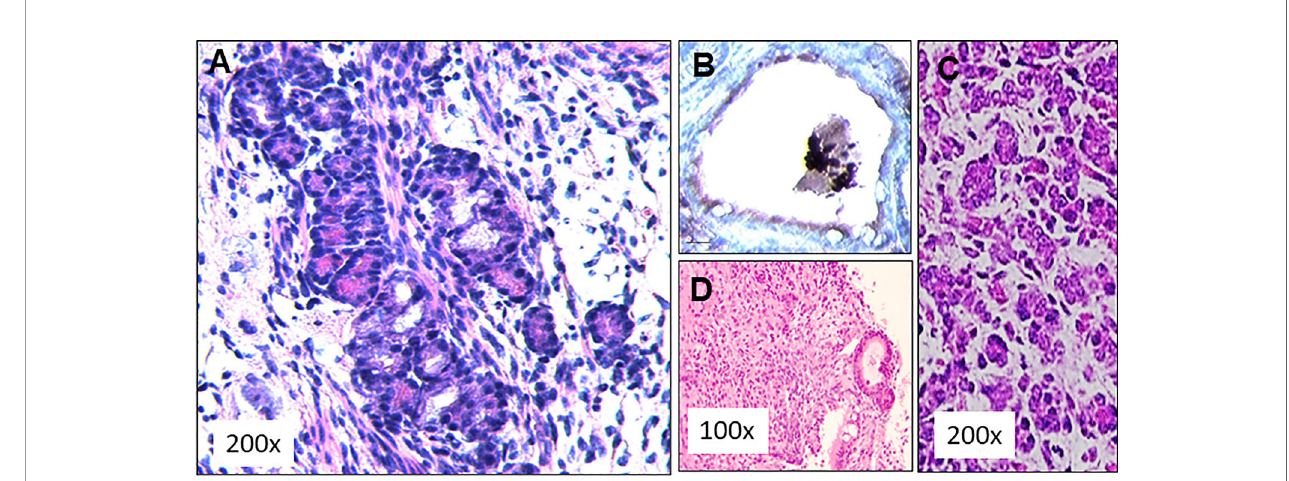
FIGURE 6 | SCID mouse transplant histology. (A) Subcutaneously implanted dermal tissue was analyzed histologically for the presence follicular structures. A large number of rudimentary follicular like structures were observed (H&E staining). (B) These follicular structures were stained for the presence thyroglobulin (Tg) using an anti Tg antibody. Intracellular Tg was observed in peripheral follicular cells but the central colloid remained negative for Tg, (C) This picture from a 13 day normal fetal thyroid shows some similarities to the histology obtained in the 4 week transplant samples. (D) Histological staining of the tissue from 3 of these mice showed undifferentiated cells between thyroids like structures indicating anaplastic tumor initiation at the implanted sites.